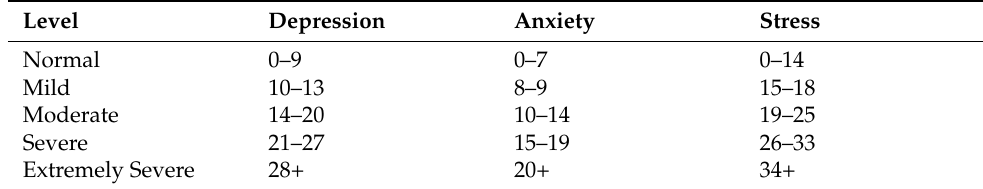
Table 1. Scoring the severity of depression, anxiety, and stress. Level Depression Anxiety Normal